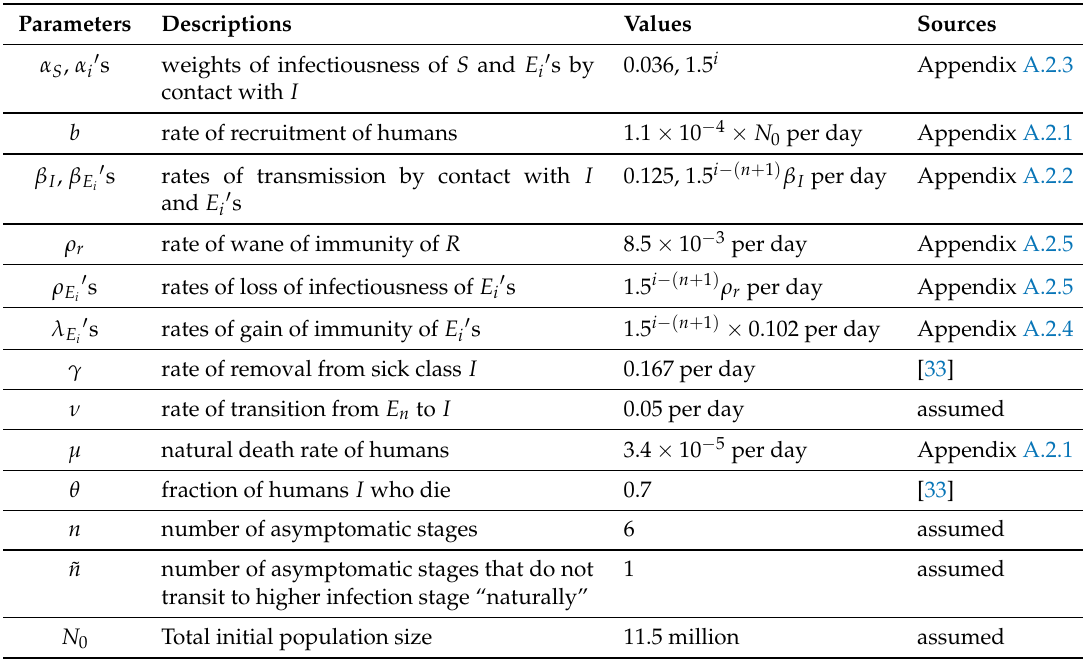
Table 2. Values for the parameters used in Model